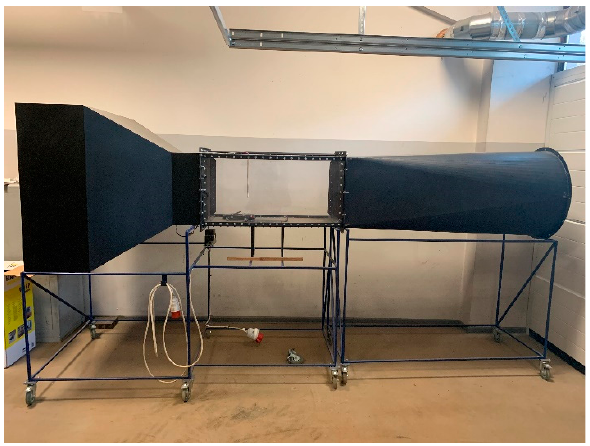
Figure 3. Wind tunnel.